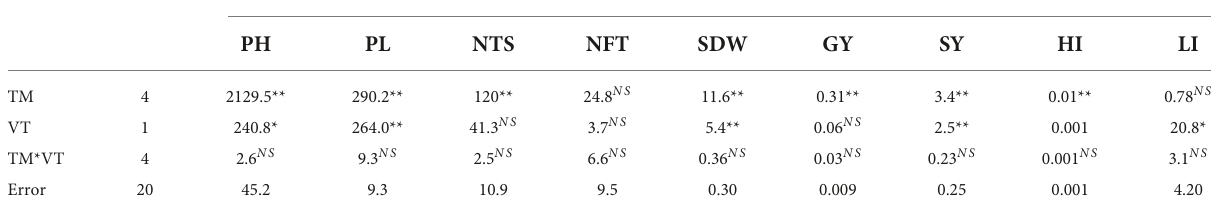
TABLE 2 Probability values for treatment, variety, variety and treatment interaction effects on growth, yield and related traits of teff.